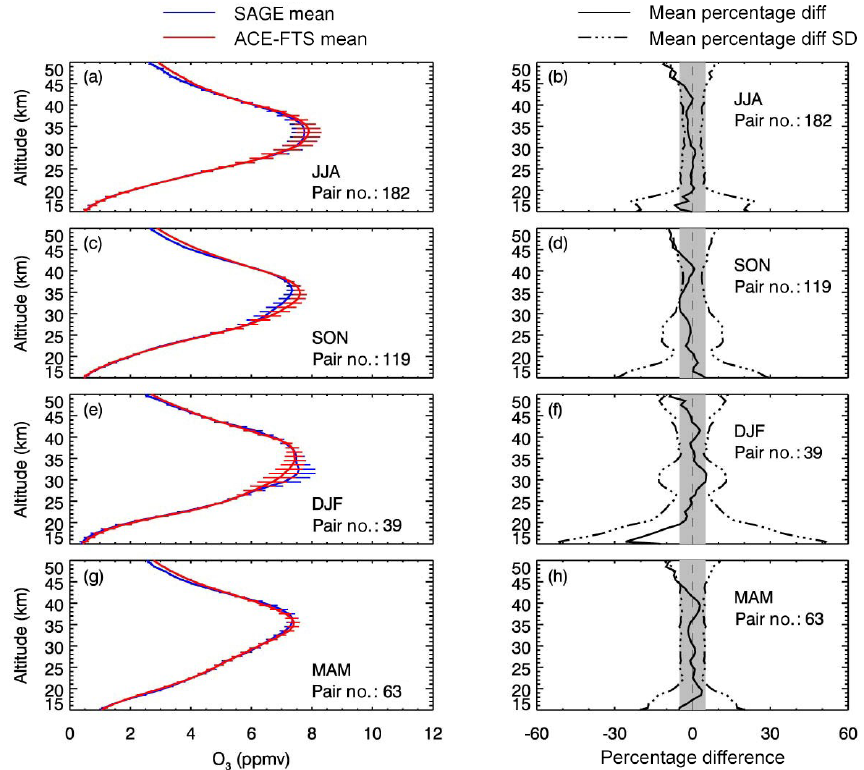
Figure 7. Seasonal average ozone mixing ratio profile comparisons between coincident SAGE III-ISS and ACE-FTS measurements for the Northern Hemisphere criteria that are described in Fig. 6. The SAGE III-ISS average ozone mixing ratio profiles are shown using the blue solid line with twice the standard error ( ± 2SEM) shown as horizontal blue error bars. The ACE-FTS average ozone mixing ratio profiles are shown using the red solid line with twice the standard error shown as the horizontal red error